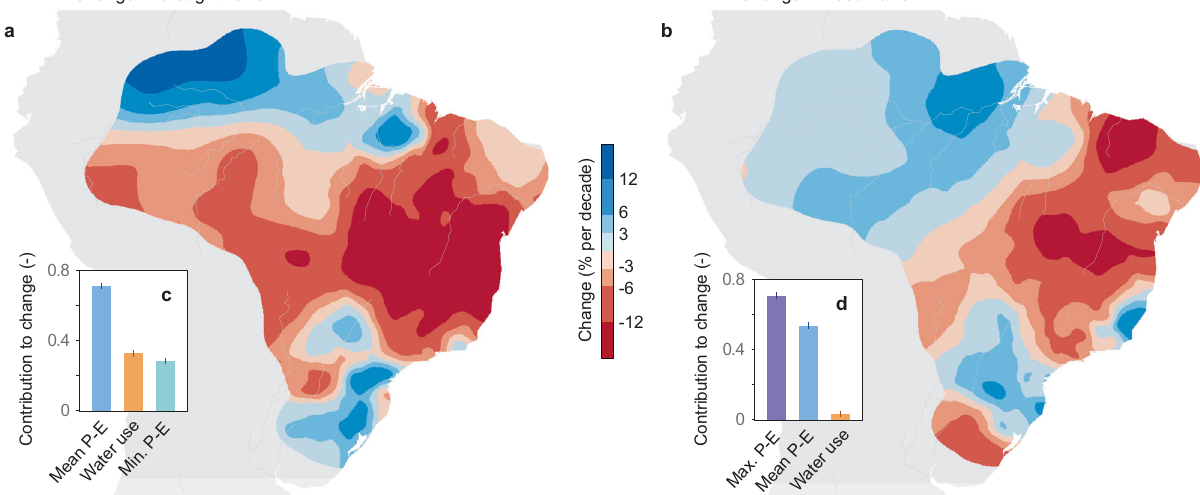
Fig. 1 | Observed stream fl ow trends and their drivers in Brazil (1980 –